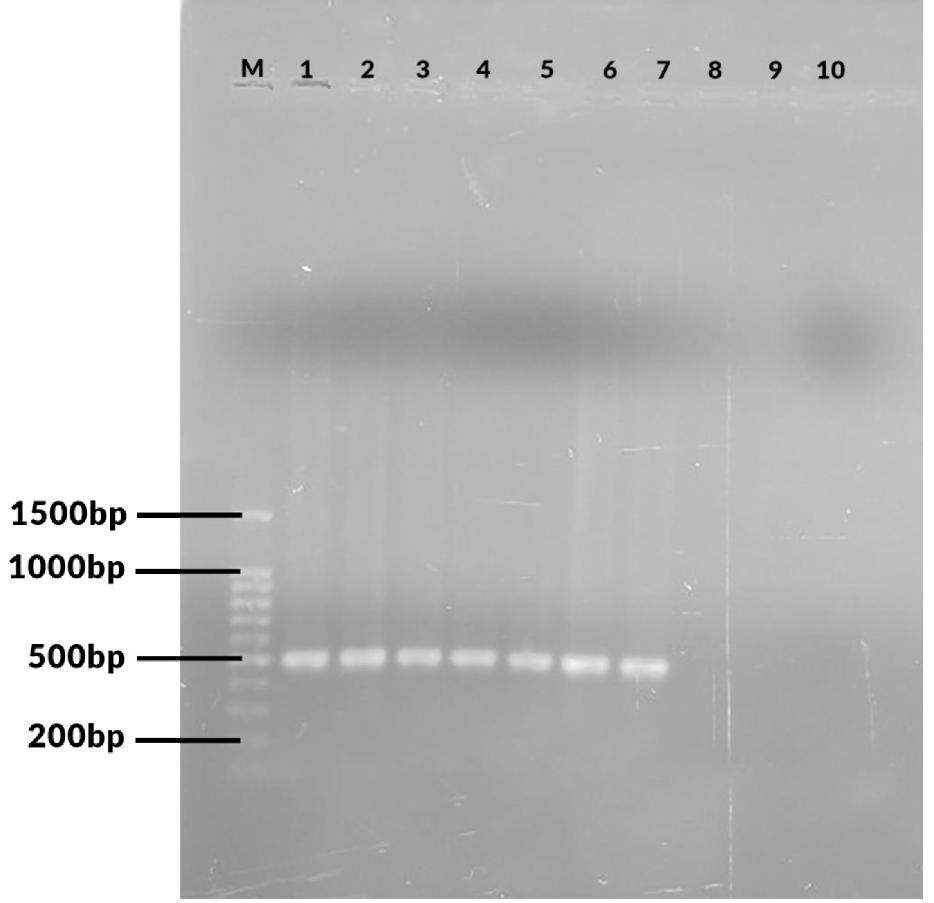
Fig 2. AMOS PCR, gel electrophoresis showing 100bp molecular marker (M), positive human samples 1,2,3,4,5,6,7 ( B . abortus (498bp) negative human samples 8, blank well 9 and negative control 10.